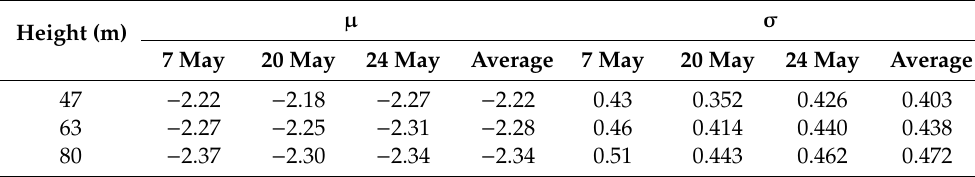
Figure 4. The fitted lognormal distributions of dust particles proportions at the 47 m, 63 m and 80 m heights of the three dust storms ( a ) 07 May ( b ) 20 May ( c ) 24 May. Table 3. The parameters of the fitted lognormal distributions.